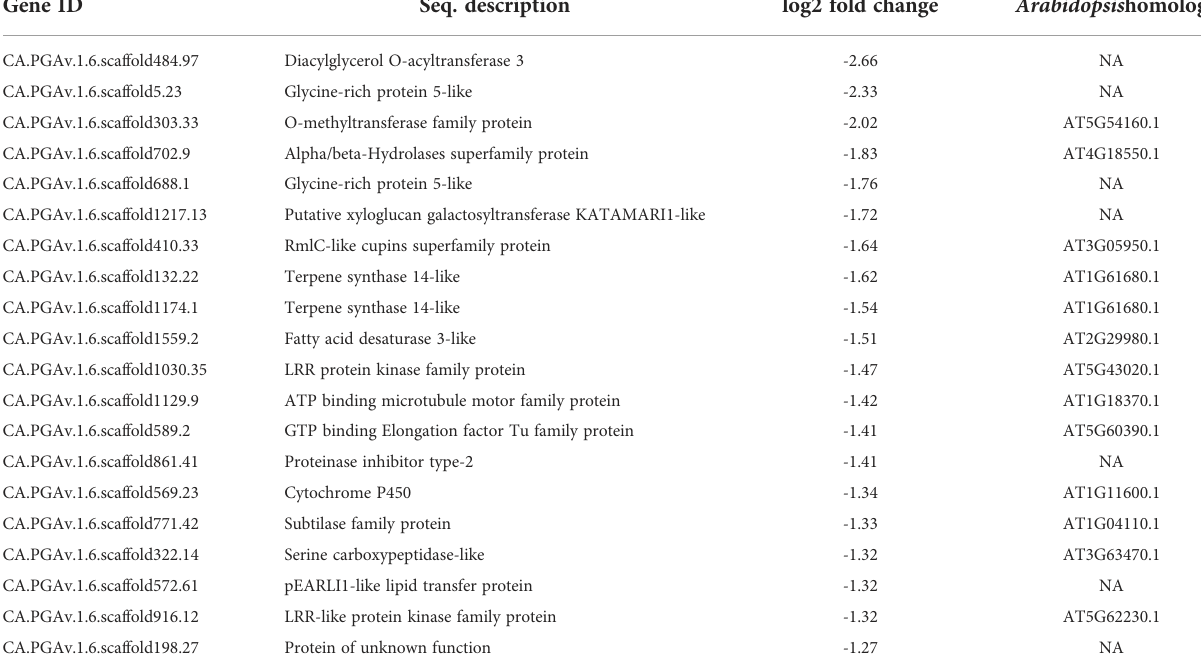
TABLE 2 Top 20 downregulated DEGs in response to infection with